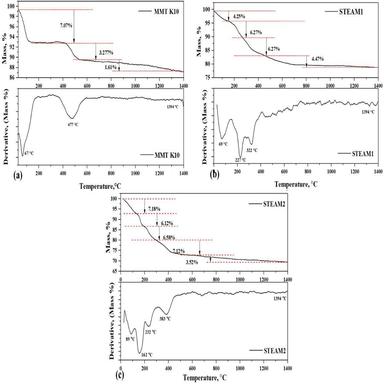
TGA and DTA relationships with temperature: (a) MMT K10; (b) STEAM1; (c) STEAM2.